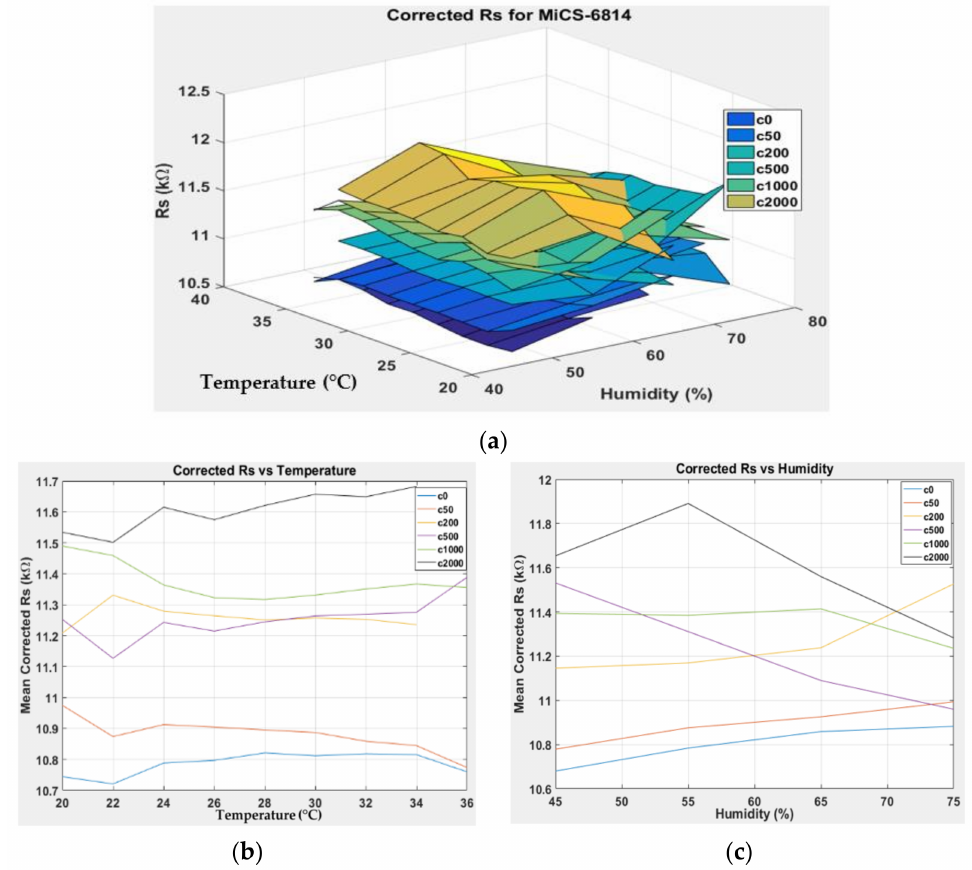
Figure 15. ( a ) Three-dimensional surface graph of MiCS-6814 corrected R S using m5 model at varying temperature and humidity levels and different ethanol solution concentrations, ( b ) mean of corrected R S versus temperature, and ( c ) mean of corrected R S versus